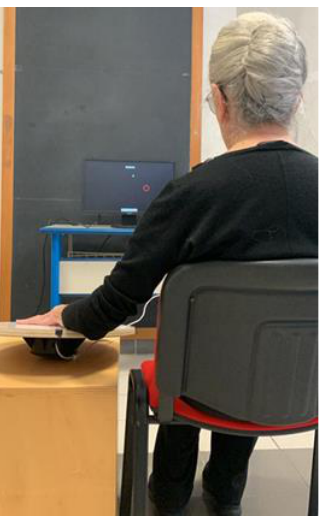
Figure 2. Standard upper limb Wobble Board test position.